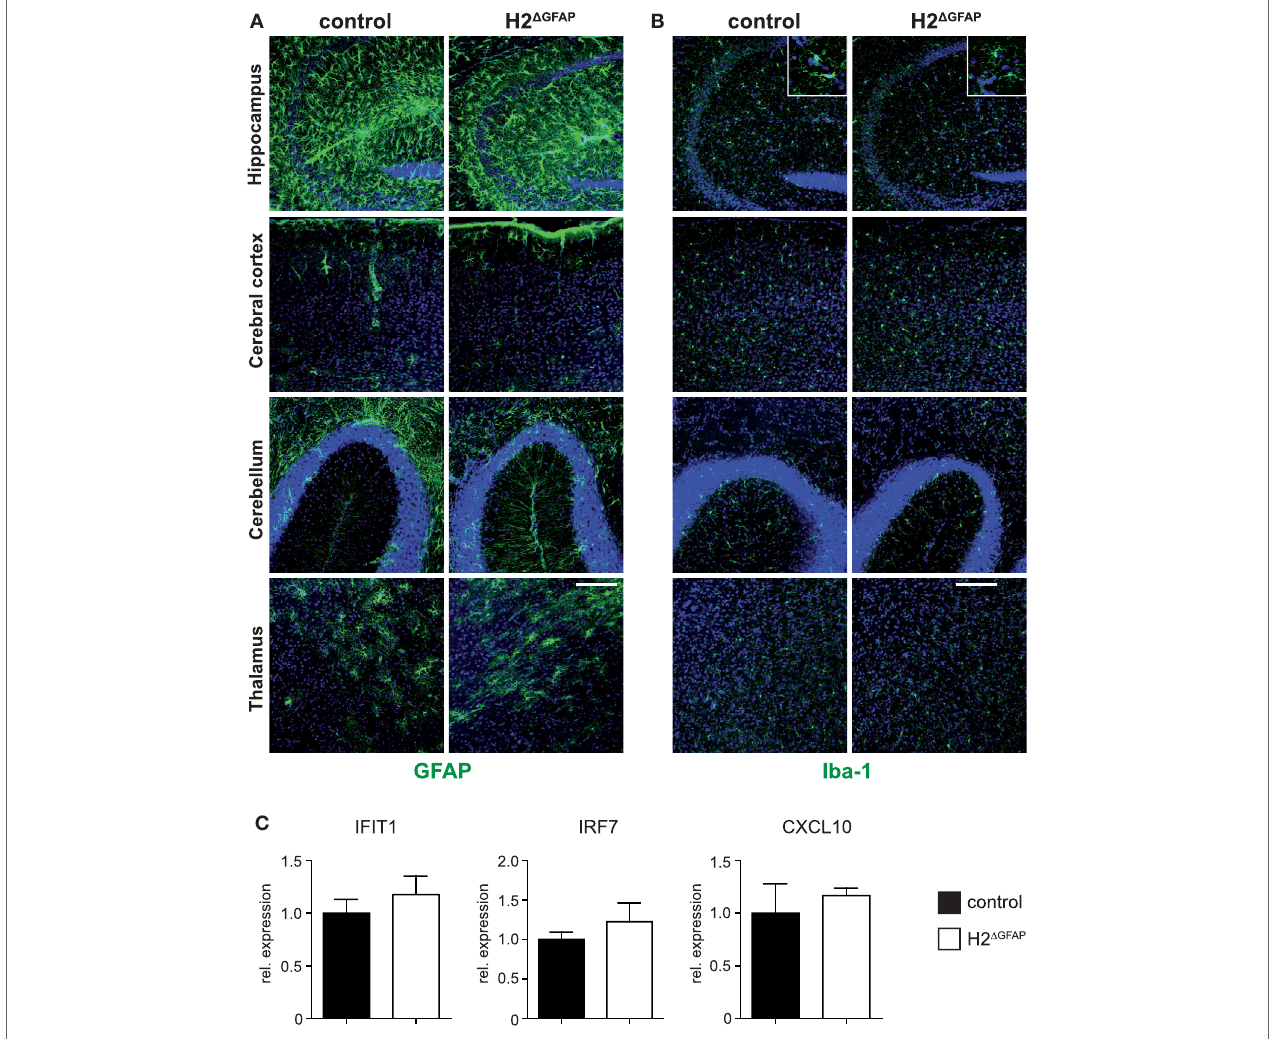
FigUre 3 | Absence of neuroinflammation in RNase H2 Δ GFAP mice. (a) Immunohistochemistry for the astrocyte marker GFAP reveals absence of significant astrogliosis in the hippocampus, cerebral cortex, cerebellum, and thalamus of RNase H2 Δ GFAP mice. Astrogliosis would present as increased expression of GFAP, cellular hypertrophy with changes of astrocyte morphology or proliferation of astrocytes. (B) Comparable Iba-1 staining between RNase H2 Δ GFAP and control brains indicates absence of microgliosis in RNase H2 Δ GFAP mice (age 3 months). Inserts represent magnifications of individual hippocampal microglia showing similar morphology in both genotypes. Scale bar = 150 µm. (c) Comparable mRNA expression of IFIT1, IRF7, and CXCL10 in RNase H2 Δ GFAP and control brains ( x = 1), as quantified by qPCR. ISG expression was normalized to GAPDH. Whole brain RNA was prepared from P3-4 pups. Error bars are SEM, t -test ( n = 5 brains/